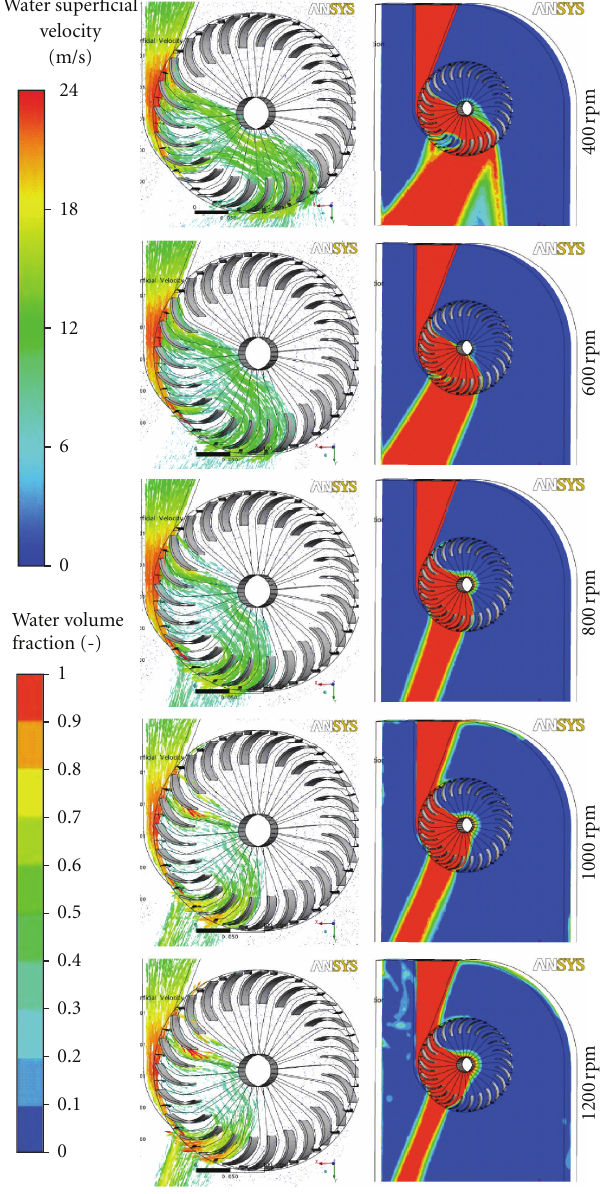
Figure 12: Contours of volume fraction and water superficial velocity vectors at midspan from simulated runner speeds n = 400, 600, 800, 1000, and 1200